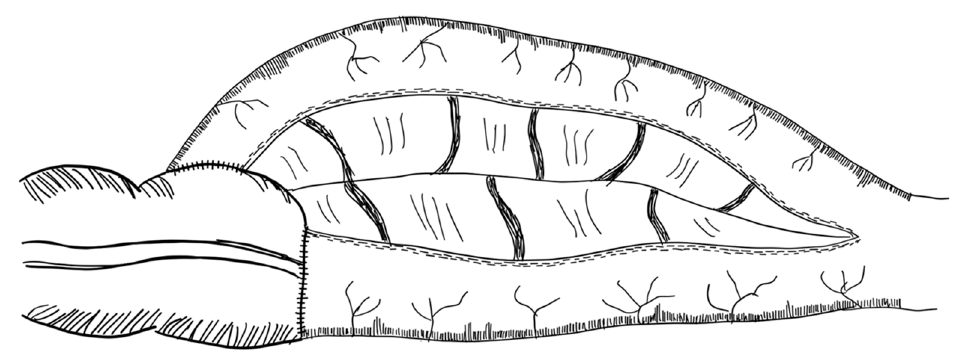
Figure 5. Dilated small intestine is longitudinally separated, creating two narrow tubes which are then reconnected to the colon. If the colon caliber is normal or small, one tube is anastomosed to the side of the colon. Shun et al. [123].